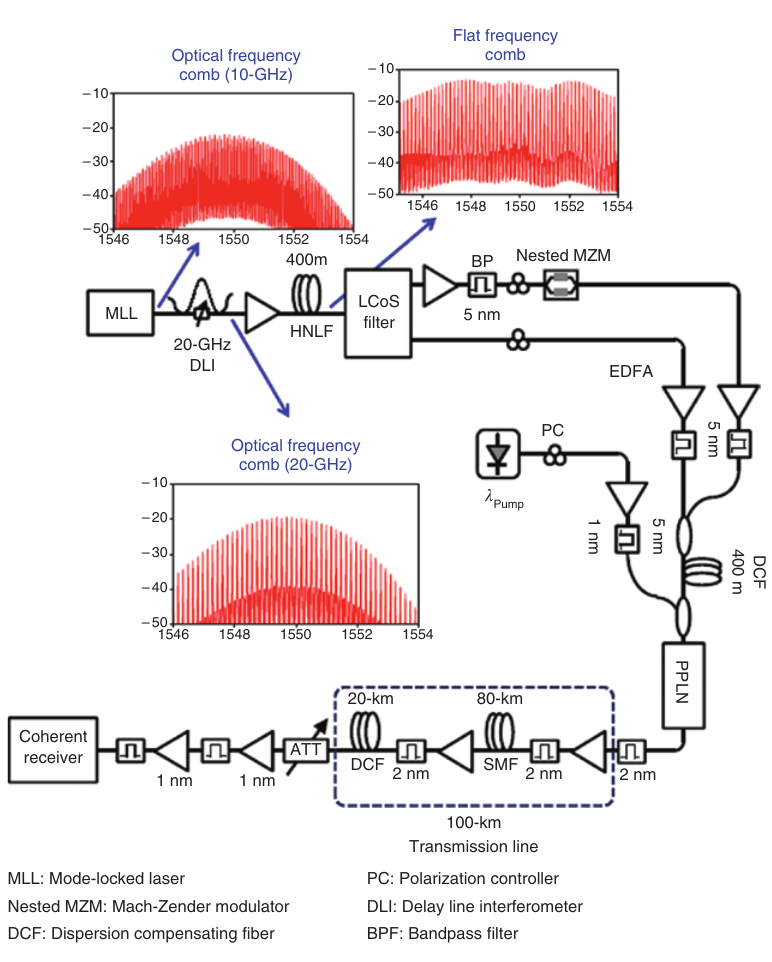
Figure 30: Aggregation system